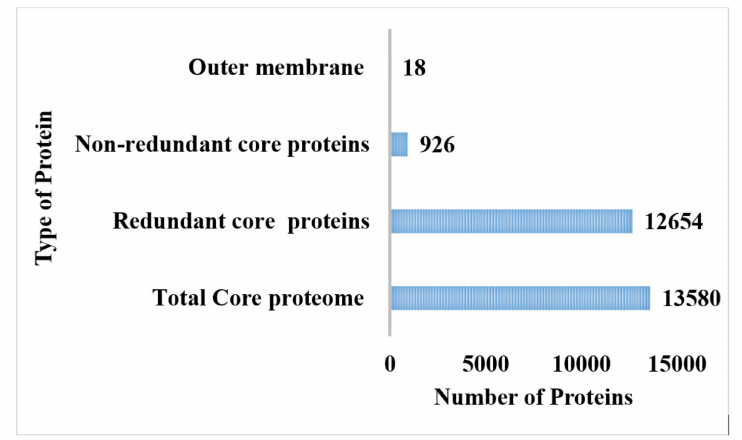
Figure 2. Number of the total proteome, core proteome, and redundant, non-redundant, and virulent